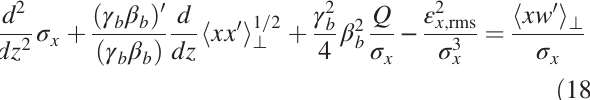
Þ of a proton in solid aluminum b